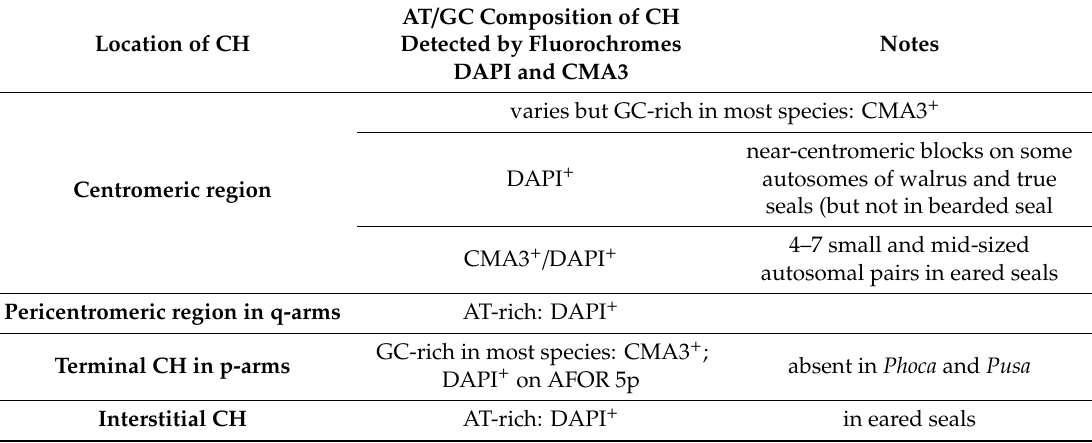
Figure 4. CDAG staining of metaphase spreads of pinnipeds: GTG banding (left) followed by formamide heat denaturation and CMA3 / DAPI staining (right). ( a ) The walrus (OROS), ( b ) bearded seal (EBAR), ( c ) ringed seal (PHIS), ( d ) Baikal seal (PSIB), and ( e ) northern sea lion (EJUB). Table 2. Distribution and nucleotide composition of the heterochromatin blocks in